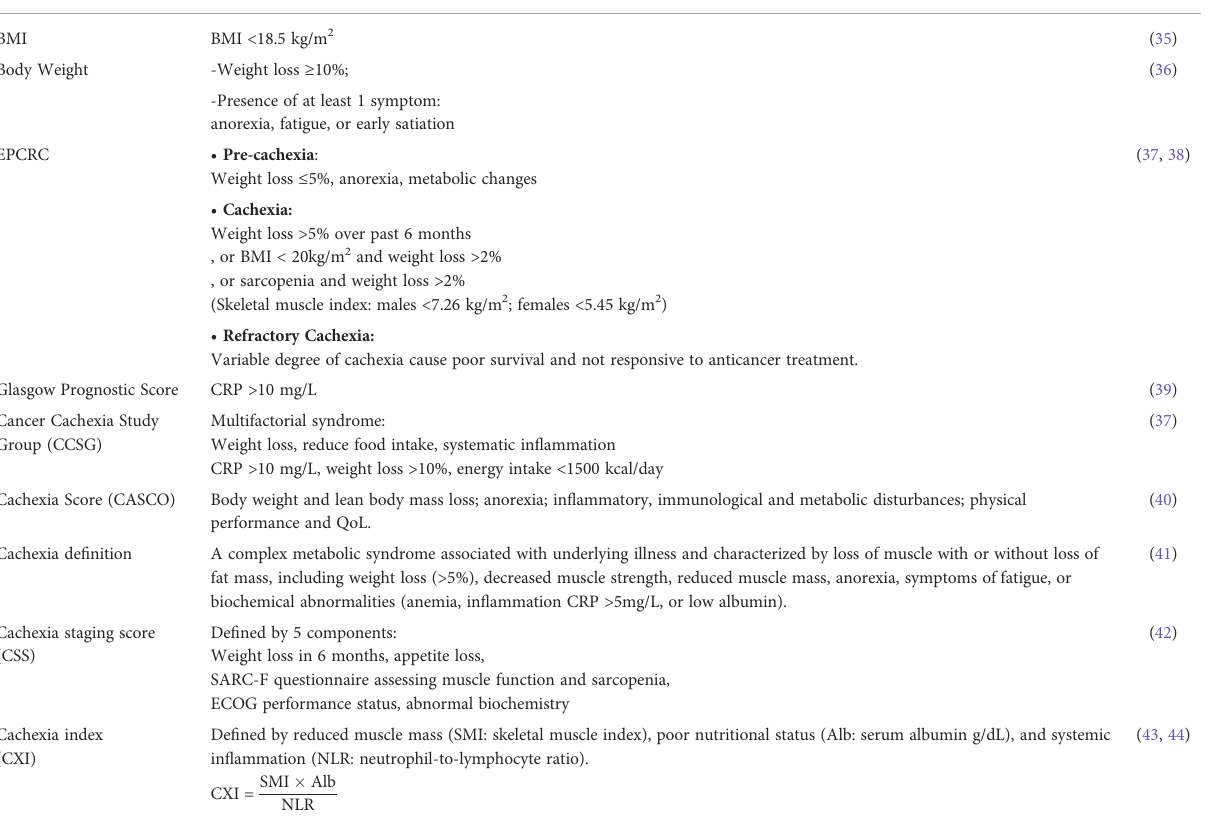
TABLE 1 Cachexia criteria/de fi